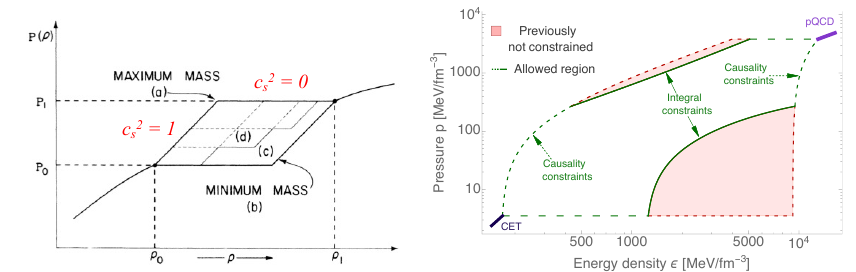
Figure 2. (Left) The robust equation of state constraints arising from knowing the high-density limit of the reduced equation state by Rhoades and Ru ffi ni, figure from [21]. Any equation of state connecting the low- and high-density limits with a causal and stable interpolation will necessarily lie inside the rhomboid. (Right) The robust equation of state constraints of [22], requiring stability, causality and thermodynamic consistency. The dashed lines correspond to the rhomboid of Rhoades and Ru ffi ni (in logarithmic scale), the "integral constraints" are due to requirement of thermodynamic